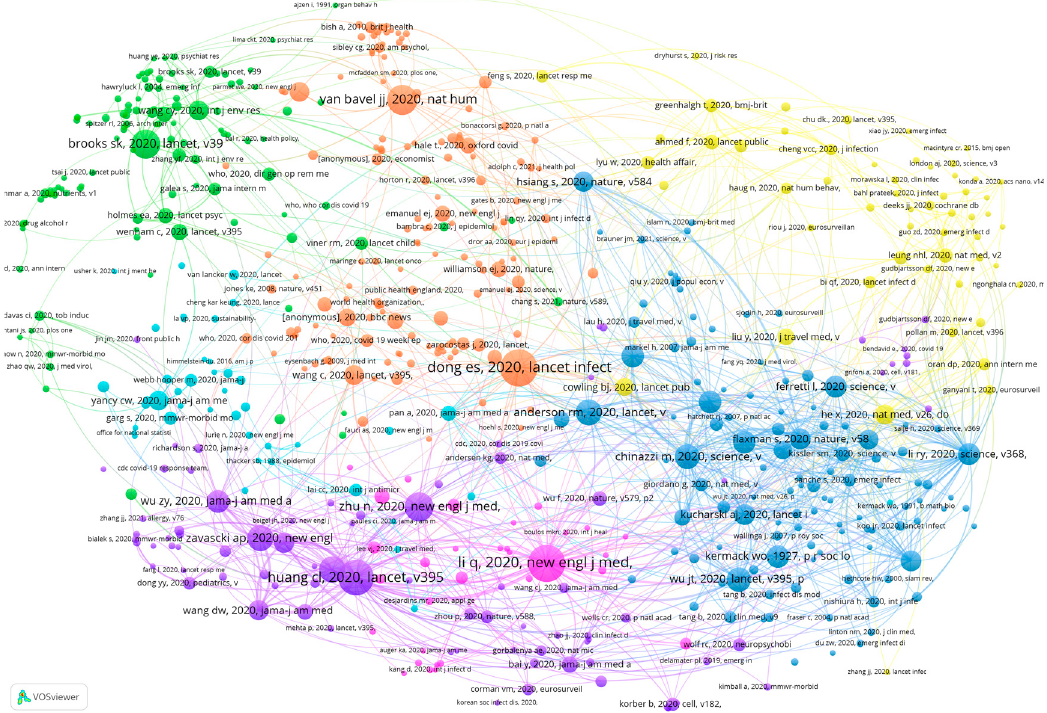
Figure 9. Co-citation network of cited references. Note(s): Node size refers to the citations; colour refers to the clusters.